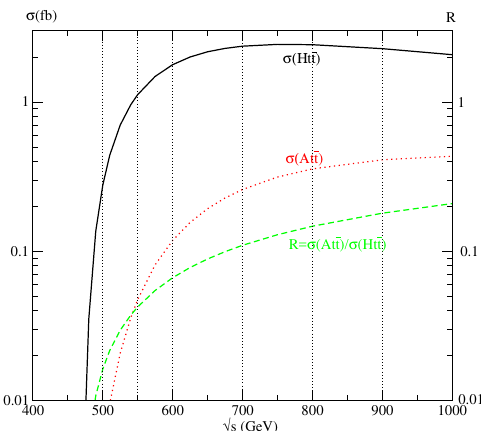
ht (cid:22) t for the pure CP-even ( h = H ) !